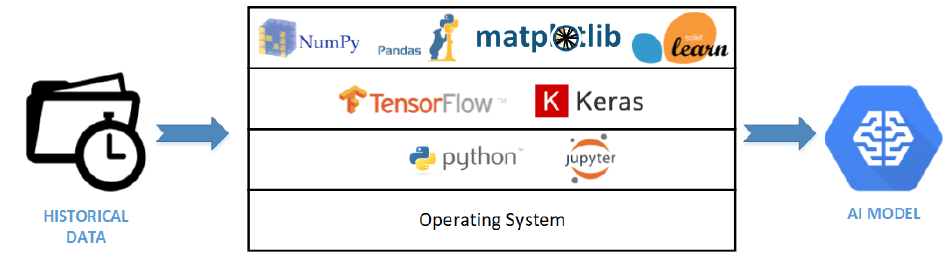
Figure 1. System Architecture.